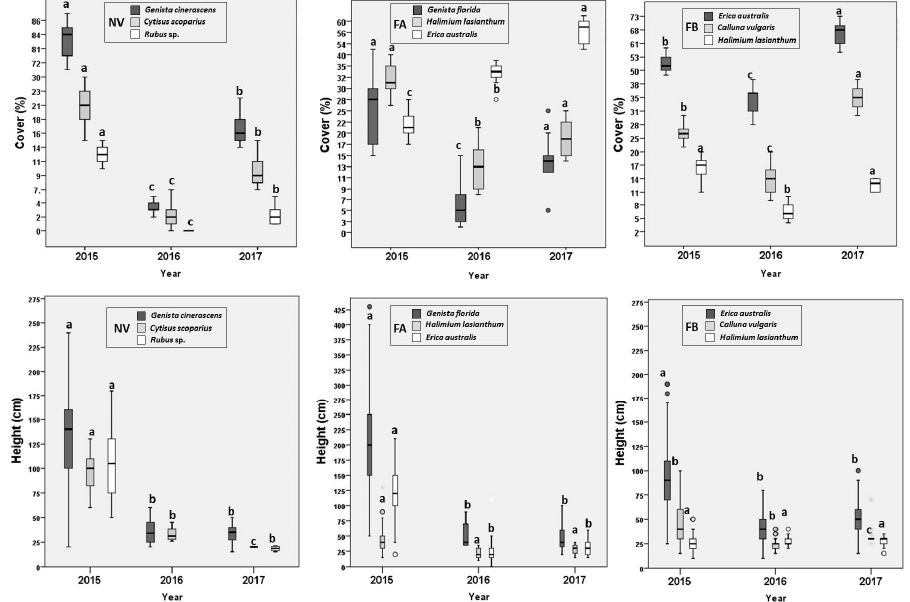
Figure 2. Percentage coverage at species level as well as their height for each location (NV, FA, and FB) before (2015) and after (2016 and 2017) harvesting. Values followed by the same letter do not differ significantly according to Newman-Keuls test ( p < 0.05).